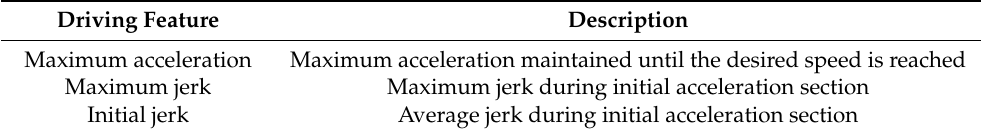
Table 1. Specification of the vehicle (Hyundai KONA).